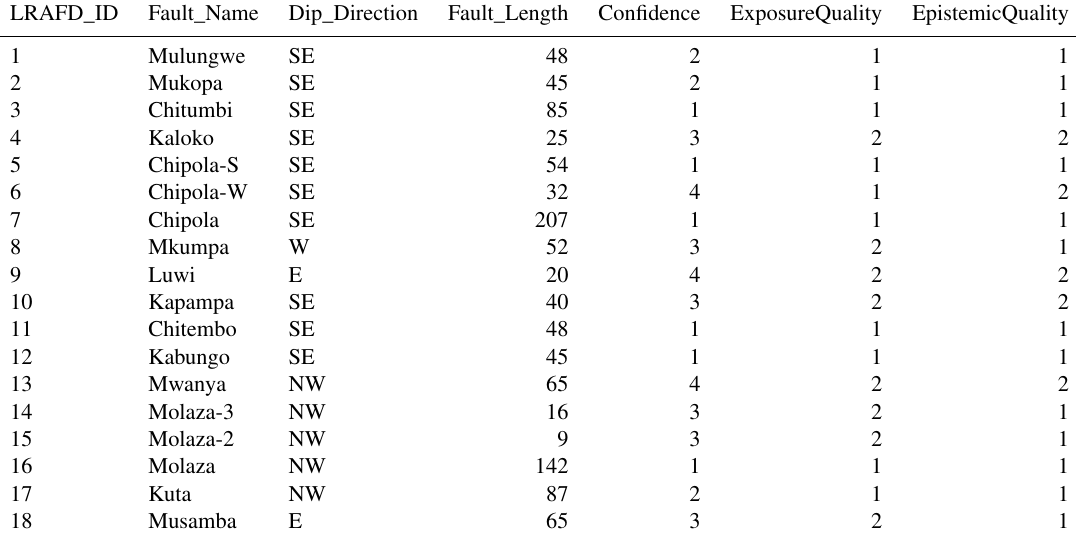
Table 2. Abridged version of the Luangwa Rift Active Fault Database (LRAFD). The full version of the database can be accessed at https://doi.org/10.5281/zenodo.6513691 (Wedmore et al., 2022). See Table 1 for a description of the attributes.